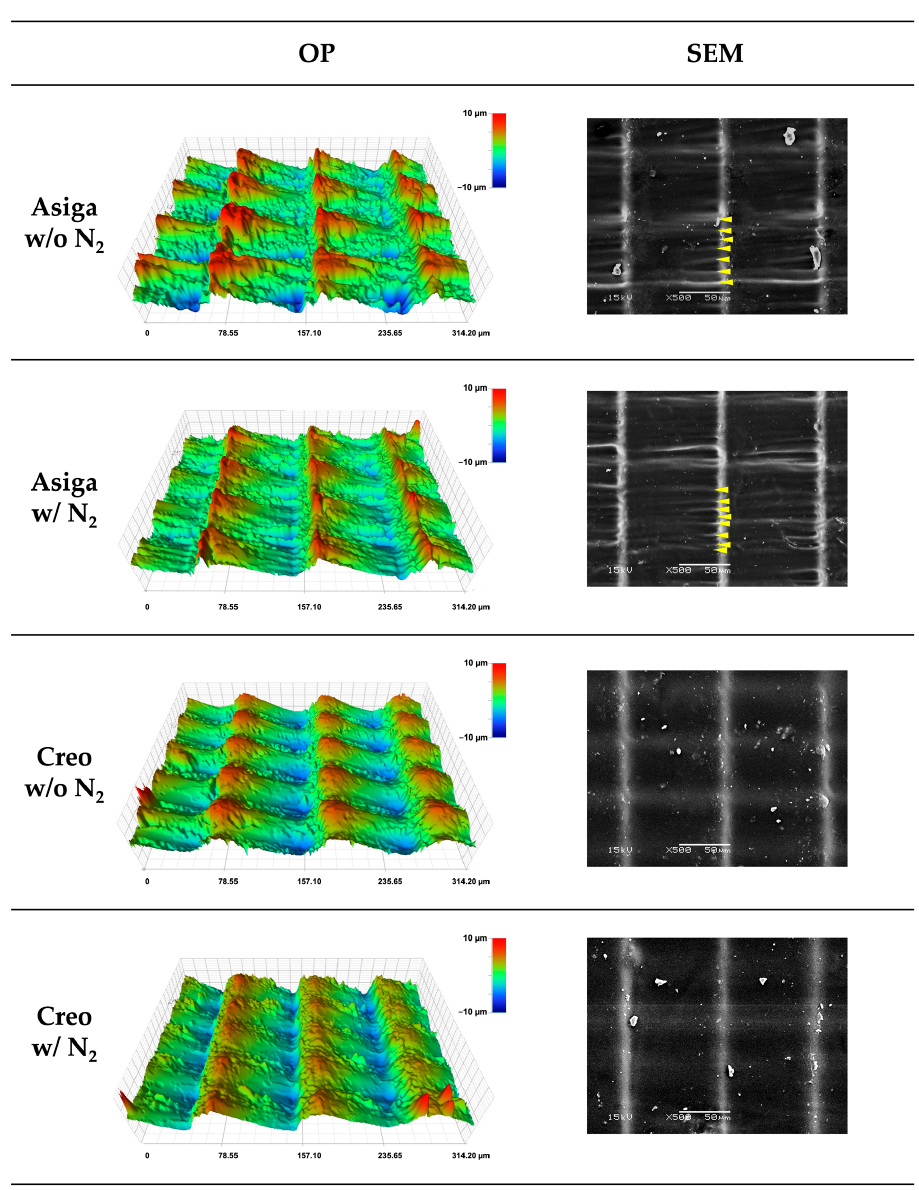
Figure 6. Optical profilometer (OP) images and scanning electron microscope (SEM) images (×400 at 15 kV) of microlayer structure in typical specimens. It was noted that the greater and rougher microlayer structural units with wavelike structures (yellow arrows) were observed in Asiga specimens compared to Creo specimens and no obvious difference was found between specimens post-cured with and without N 2